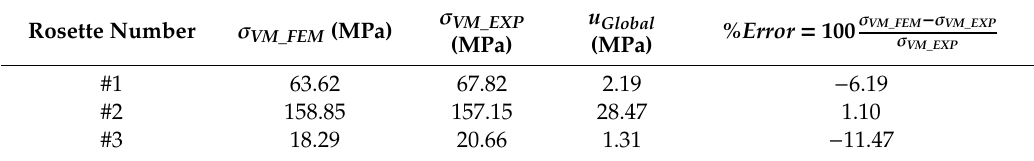
Table 12. Final experimental and numerical Von Mises stress for the three studied zones.